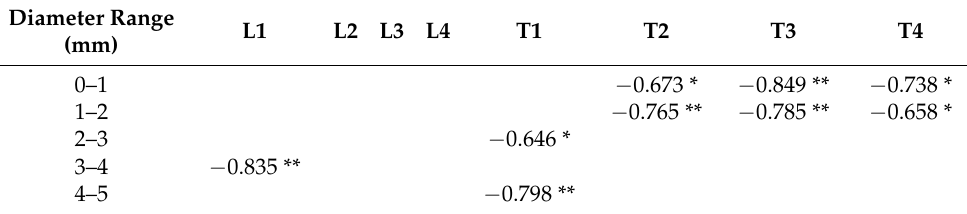
Table 3. Correlation between nitrate nitrogen content and roots with different